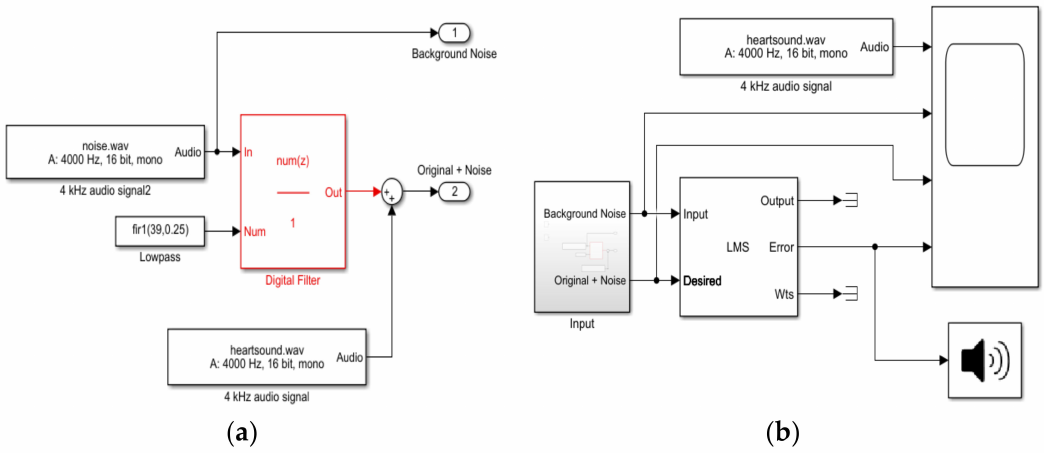
Figure 10. SIMULINK model: ( a ) block model designed to generate the simulated data and ( b ) LMS testing model.